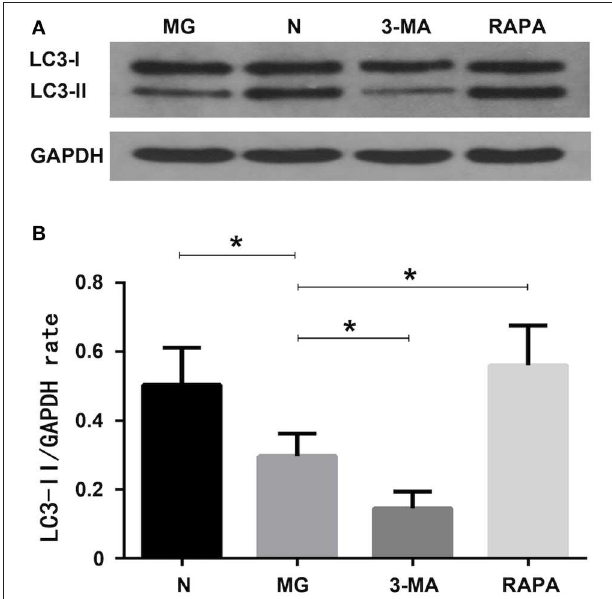
FIGURE 3 | Autophagy-related protein expression of LC3-II. (A) Western blot detection findings; (B) Statistical analysis of the four groups (* P < 0.05).